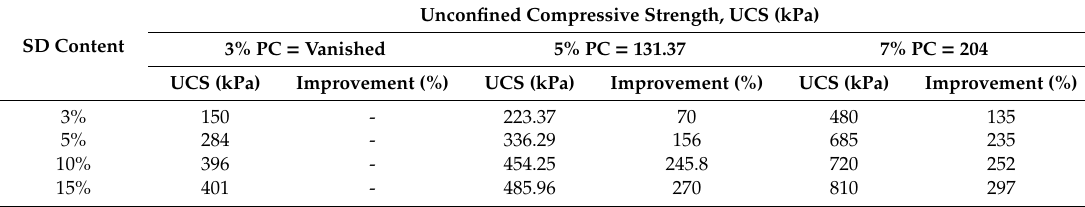
Table 7. UCS results after sulphate exposure in presence of SD (7 days